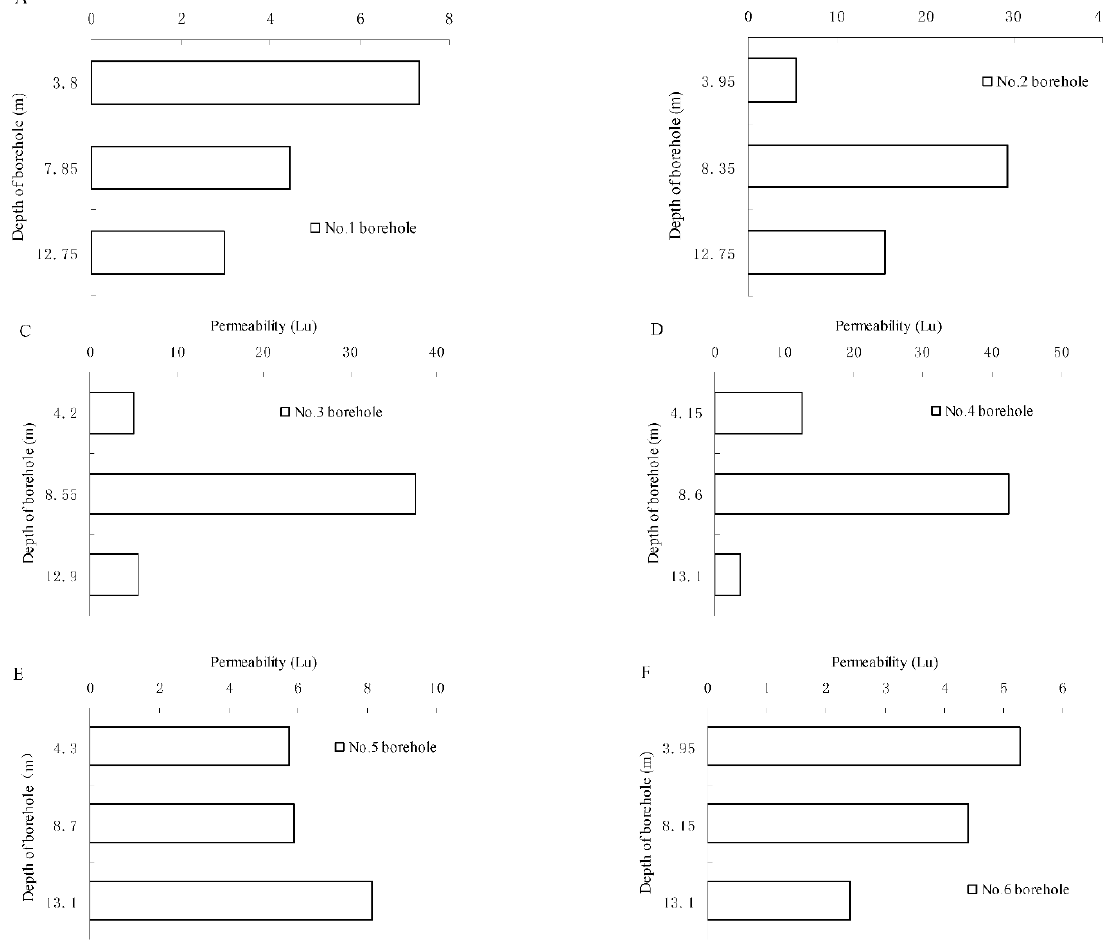
Figure 7. Relationship between permeability of RFC and depth by histogram.